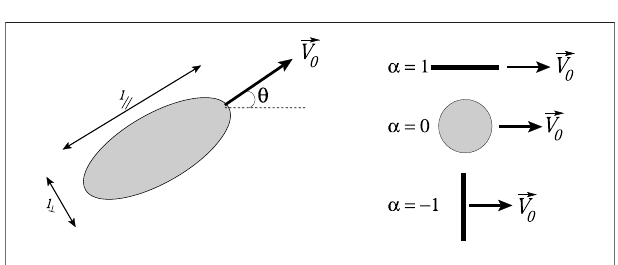
FIGURE 2 | Sketch of ellipsoidal swimmer with labelled dimensions and special cases for swimmers with α = 1, 0 and − 1.